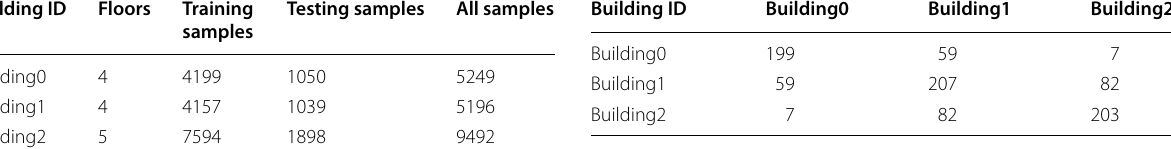
Table 1 The detailed data information for each building Building ID